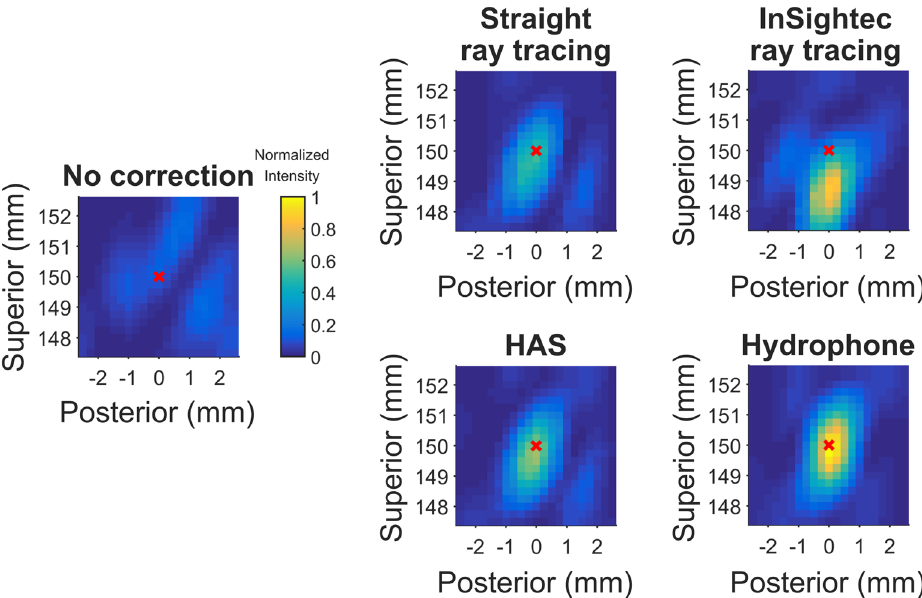
Figure 2. 2D cross section raster scans of the refocused focal spot (skull C). The sagittal view is shown. These cross sections are a subset of the 3D volume scans acquired. A red x marks the position of the target, which was placed at the geometric